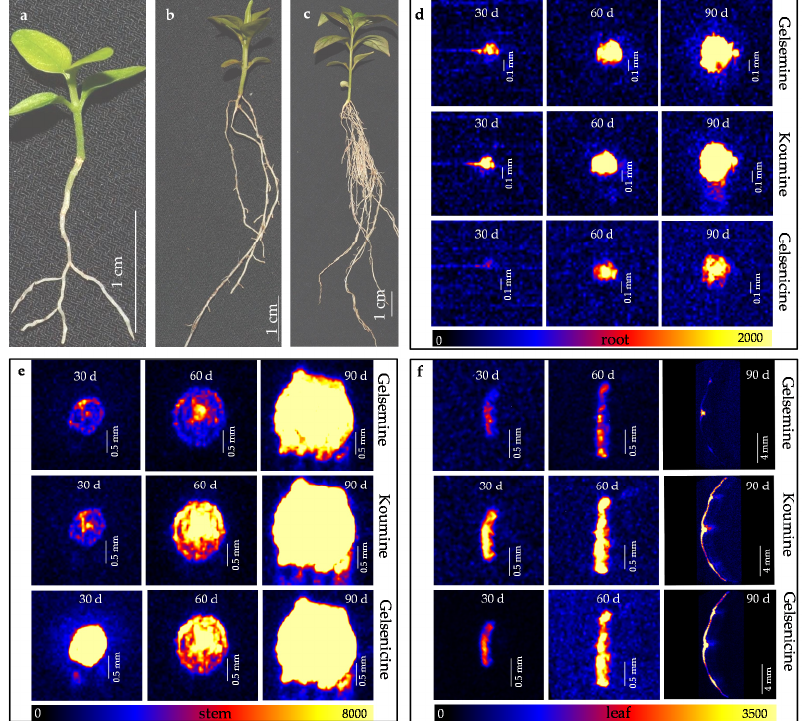
Figure 2. In situ visualization of three alkaloids in organs/tissues of G. elegans during the growth and development. 30 d ( a ), 60 d ( b ) and 90 d ( c ) old seedling of G. elegans ; ( d ) The alkaloid visualization in root of 30, 60 and 90 d old G. elegans seedling respectively; ( e ) The alkaloid visualization in stem of G. elegans seedling at 30, 60 and 90 d; ( f ) The alkaloid visualization in leaf of 30, 60 and 90 d old G. elegans seedling respectively.